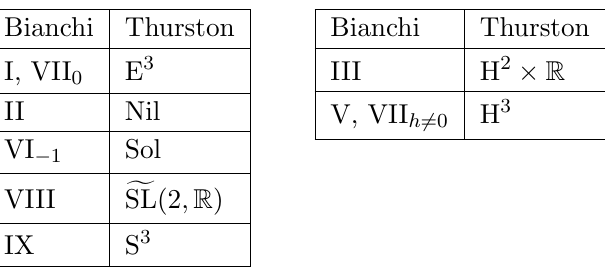
Table 1 . Class A (left) and B (right) spacetimes and corresponding Thurston